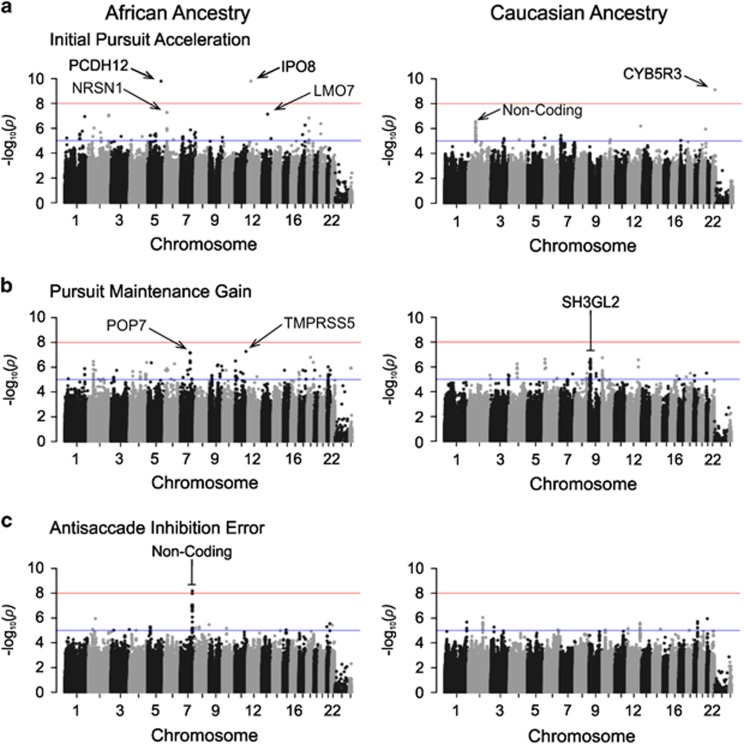
Manhattan plots from genome-wide association studies (GWAS) stratified for participants of predominantly African ancestry (N=300, left side) and participants of predominantly Caucasian ancestry (N=549, right side). Results for the three eye movement measures used as phenotypes in GWAS are depicted: (a) initial pursuit acceleration, (b) pursuit maintenance gain and (c) antisaccade error rate. For more details see Table 2.